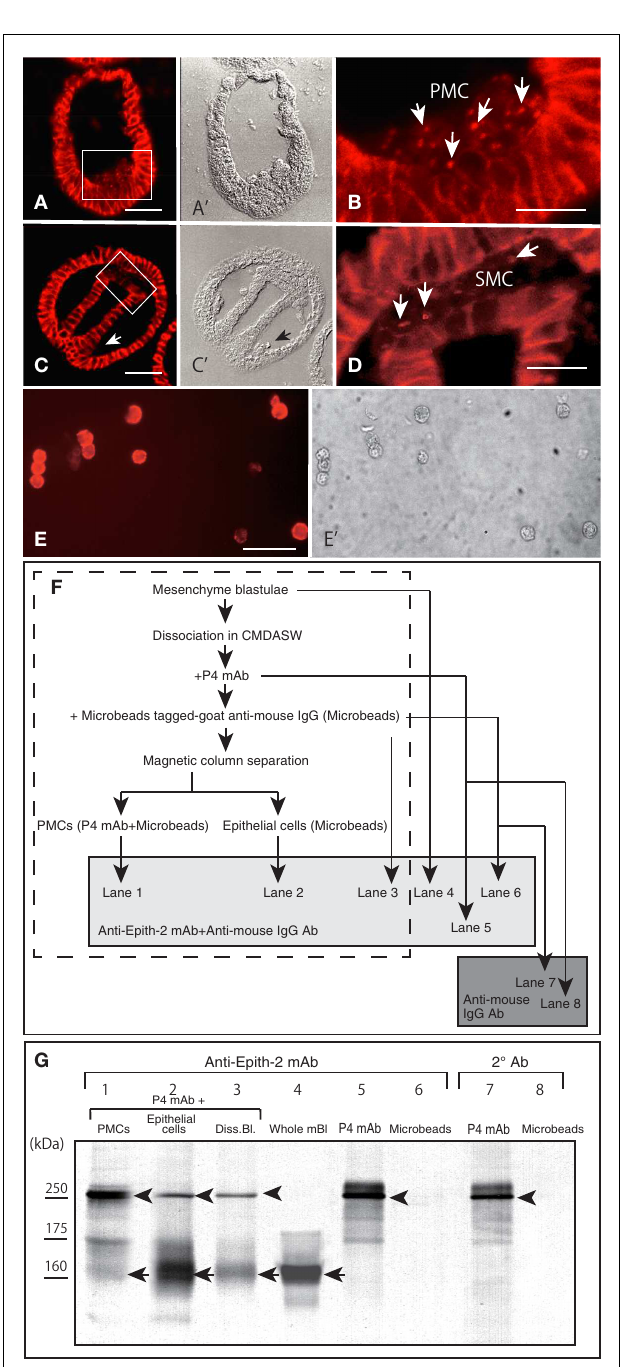
FIGURE 5 | Immunohistochemistry of Epith-2 internalization during mesenchyme ingression in H. pulcherrimus [(A–D); 6- µ m thick Polywax sections], purified primary mesenchyme cells [PMC; (E,E’)] and the fate of Epith-2 in ingressed PMCs by immunoblotting in T. hardwicki (F,G) . (A) An early mesenchyme blastula. Scale bar, 40 µ m. (A’) Phase-contrast micrograph of the same section as (A) . (B) Higher magnification image of the box in (A) . Arrows, cytoplasmic anti-Epith-2 mAb-positive dots in primary mesenchyme cells (PMC). Scale bar, 10 µ m. (C) Late gastrula. Scale bar, 40 µ m. (C’) Phase-contrast micrograph of the same section as (C) . Arrow, PMC aggregate near the blastopore. (D) Higher